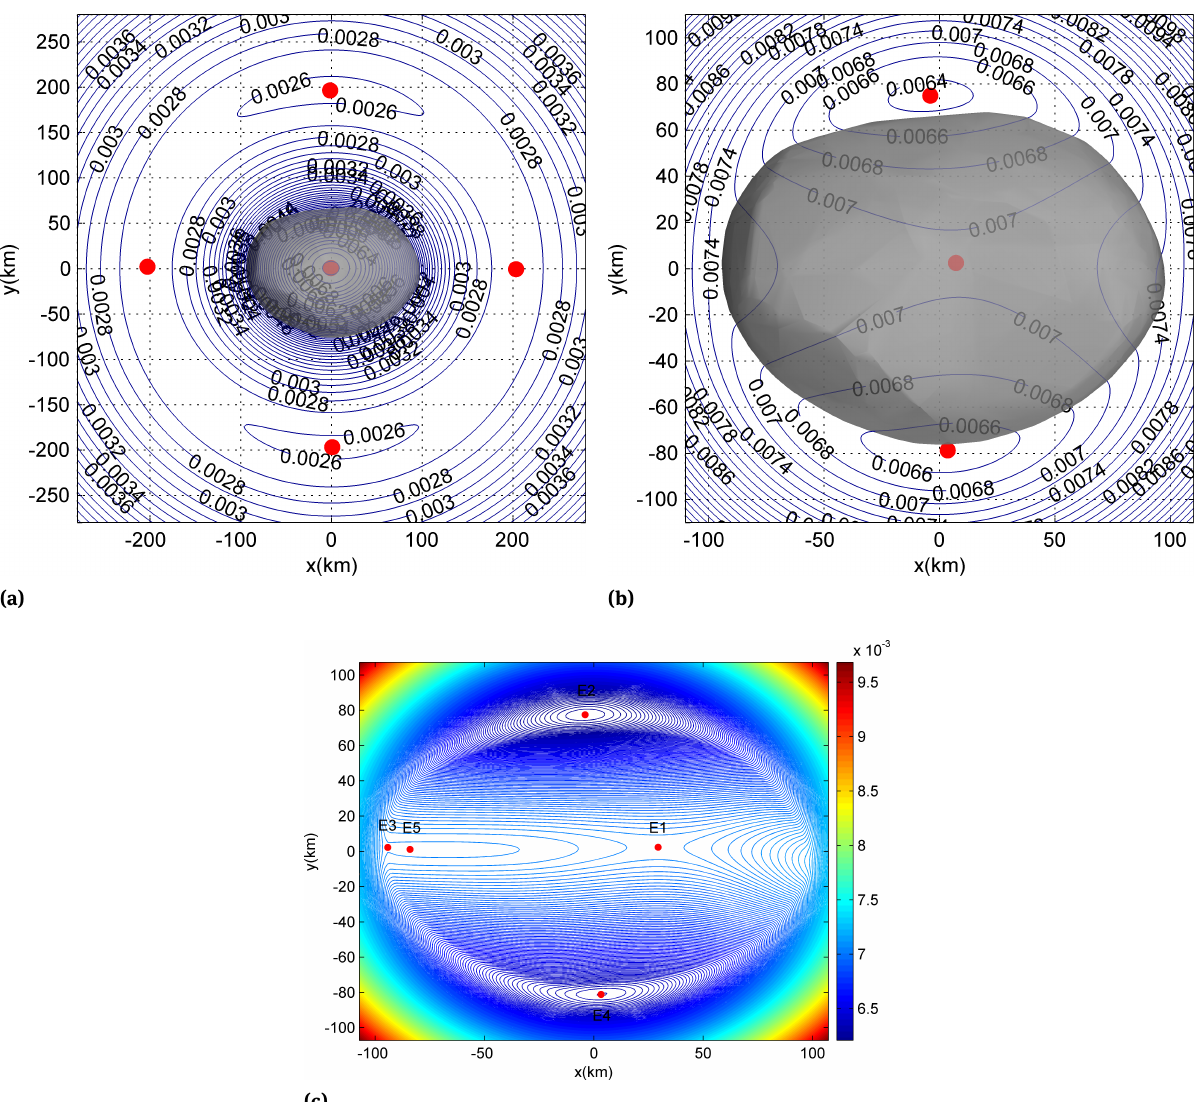
Figure 5. The locations of projections of equilibrium points in the equatorial plane during the variety of rotation speed. (a) ω =0.5 ω 0 ,